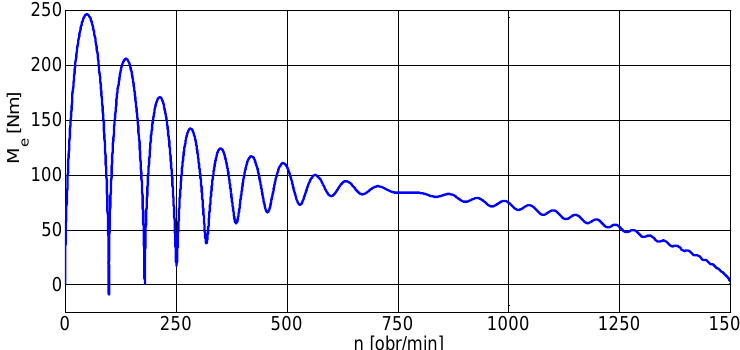
Figure 11. Torque – speed M e ( n ) trajectory of a solid-rotor induction motor during the reversion. In Figure 12, a flowchart of the calculation process is presented.